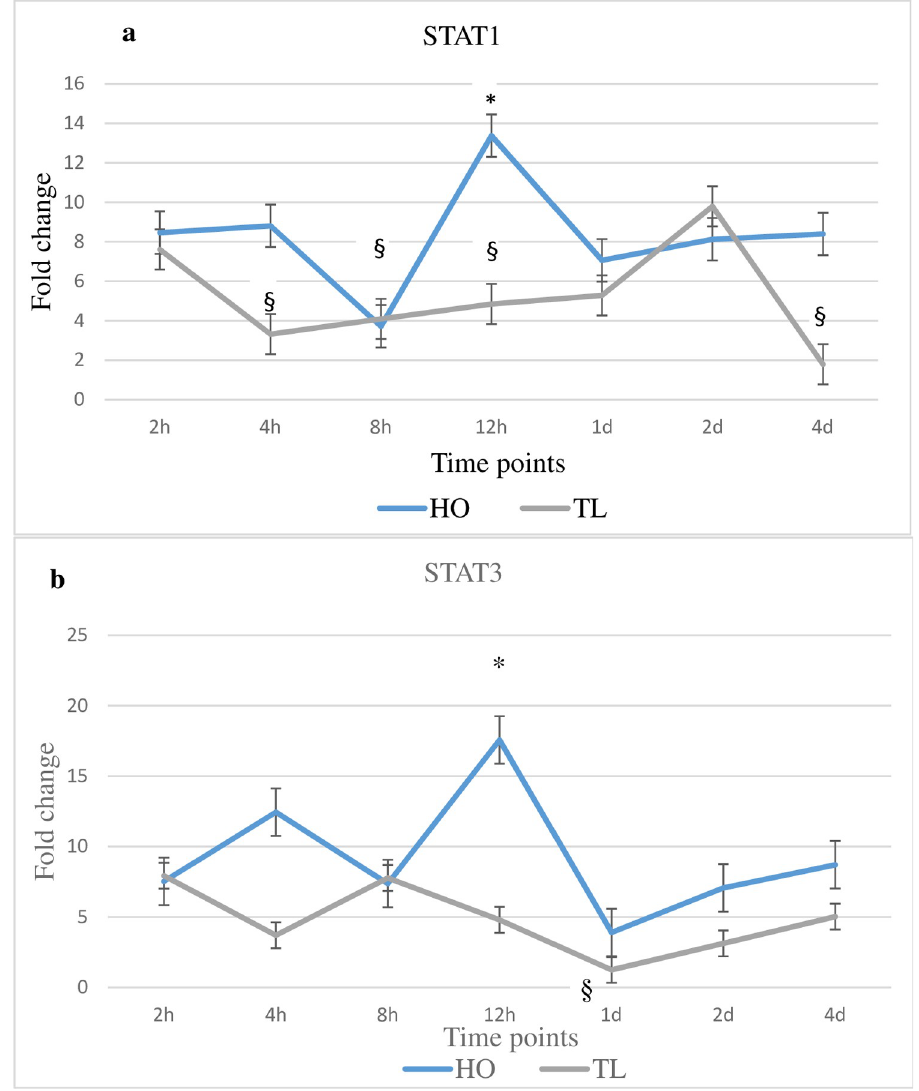
Fig 2. Transcription levels of STAT1 and STAT3. The figure shows the mean ± SD (n = 5) fold change of the genes in Myxobolus cerebralis exposed fish; resistant Hofer (HO) and susceptible Trout Lodge (TL) fish. Lines are the mean fold change of STAT1 and STAT3. and ROR- γ measured at different time points post exposure hpe/dpe. All HO and TL means are presented normalized to HO and TL timed levels of control fish ± SD (n = 5). � = significantly higher and § = significantly lower to values in non-exposed fish (p <